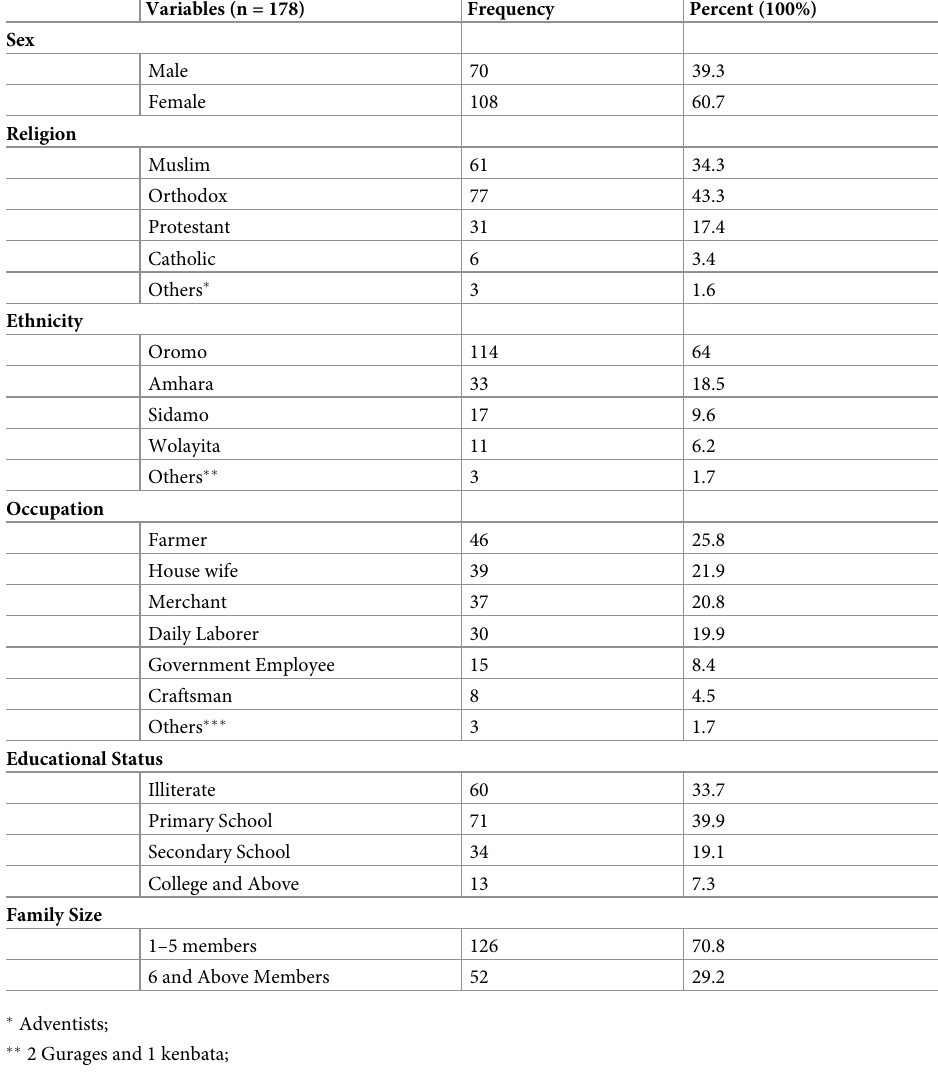
Table 1. Socio-demographic distribution of family heads of children aged 1–9 years at Arsi Negele Town, West Arsi Zone, Oromia Region, Southern Ethiopia, December, 2019.